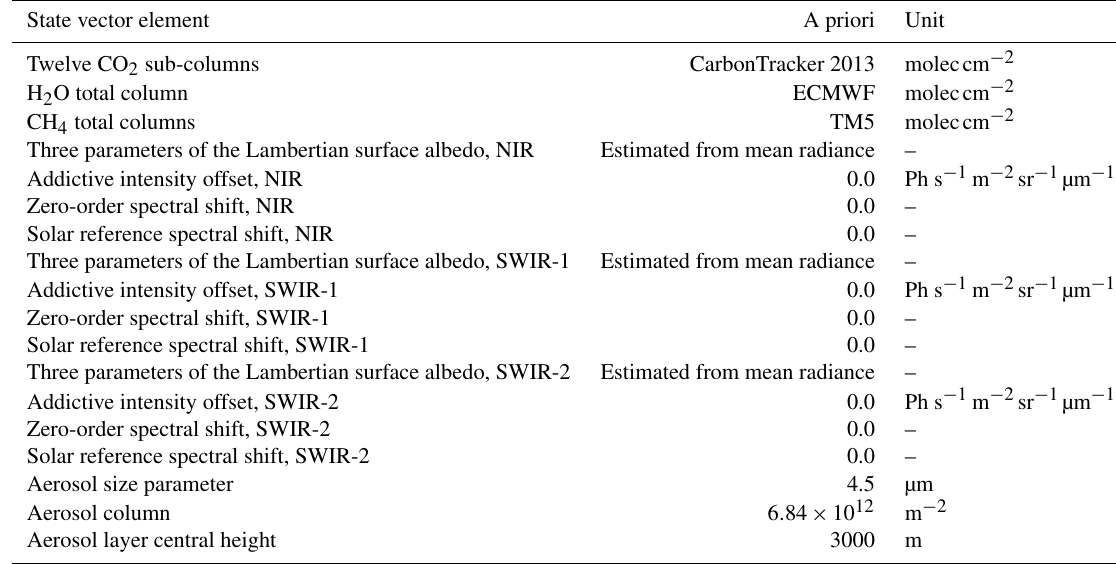
Table 1. State vector elements and their a priori values considered in the retrieval. State vector element A priori Unit Twelve CO 2 sub-columns CarbonTracker 2013 moleccm − 2 H 2 O total column ECMWF CH 4 total columns TM5 moleccm − 2 Three parameters of the Lambertian surface albedo, NIR Estimated from mean radiance – Addictive intensity offset, NIR 0.0 Zero-order spectral shift, NIR 0.0 – Solar reference spectral shift, NIR 0.0 – Three parameters of the Lambertian surface albedo, SWIR-1 Estimated from mean radiance – Addictive intensity offset, SWIR-1 Zero-order spectral shift, SWIR-1 – Solar reference spectral shift, SWIR-1 – Three parameters of the Lambertian surface albedo, SWIR-2 Estimated from mean radiance – Addictive intensity offset, SWIR-2 Zero-order spectral shift, SWIR-2 – Solar reference spectral shift, SWIR-2 – Aerosol size parameter Aerosol column Aerosol layer central